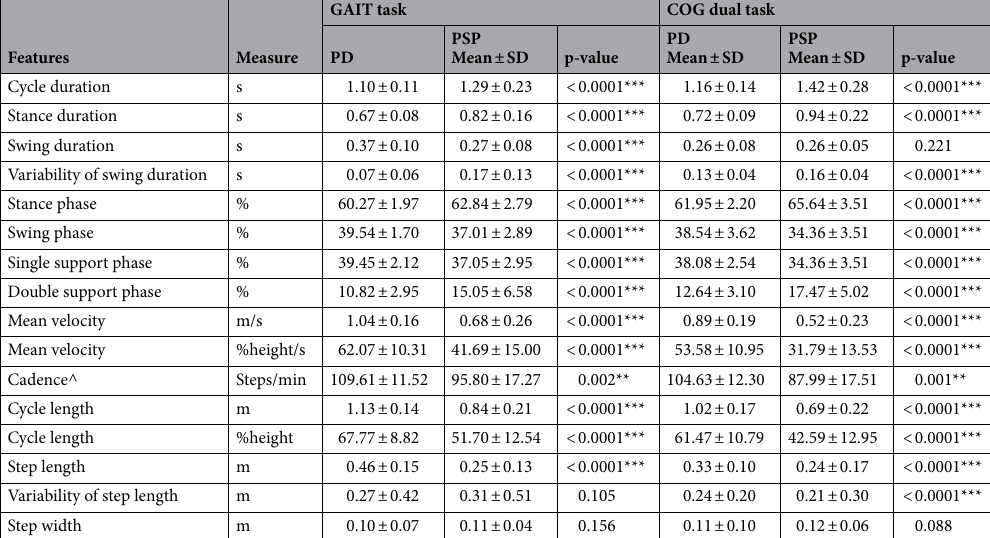
Table 2. Univariate statistical analysis comparing all gait parameters (mean ± SD) between PD and PSP patients. PD Parkinson’s disease, PSP progressive supranuclear palsy. **Significance level at 0.01. ***Significance level at 0.001. ^Normally distributed according to the Shapiro Wilk test (homoscedasticity verified for all t-tests) and t-test applied; the other data were analyzed with a Mann Whitney test.